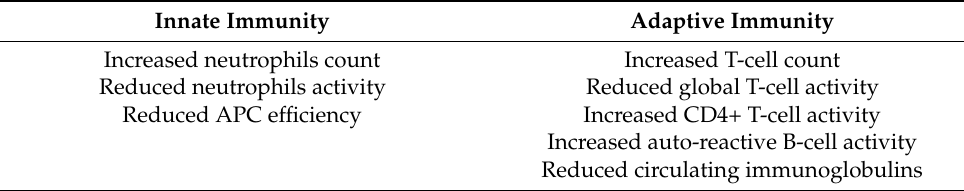
Table 2. Influence of smoking status on human immune system. Innate